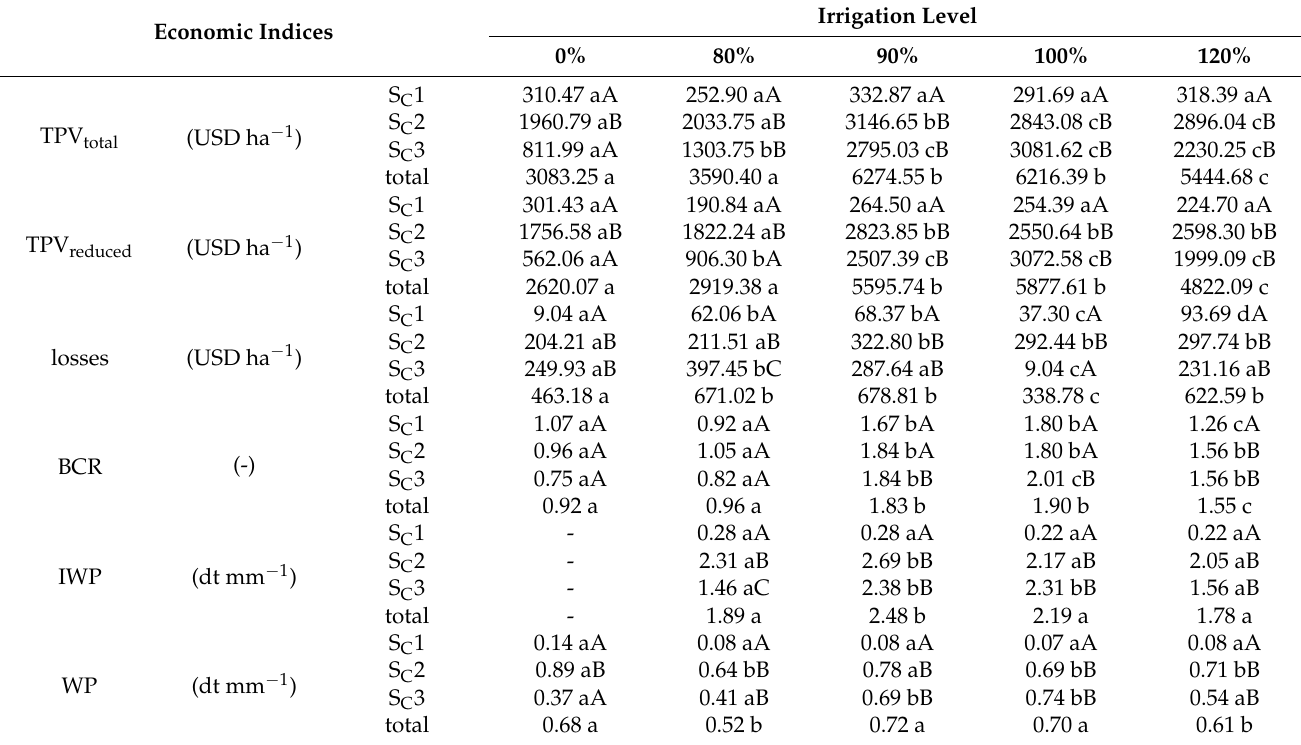
Table 5. Economic indices and responses at different irrigation levels for total yield and per tuber